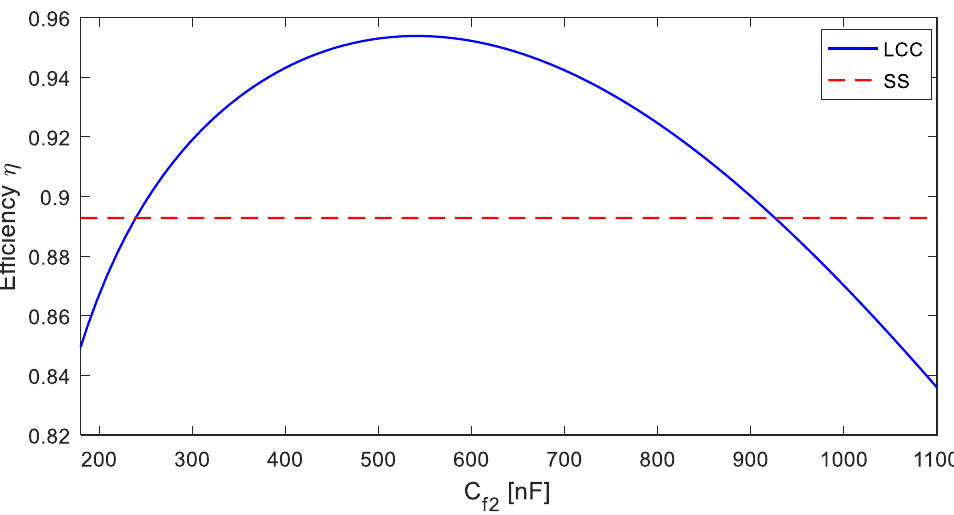
ffi ciency η using SS compensation and LCC compensation versus variable C Figure 8. System efficiency η using SS compensation and LCC compensation versus variable C f 2 . Figure 8. System e